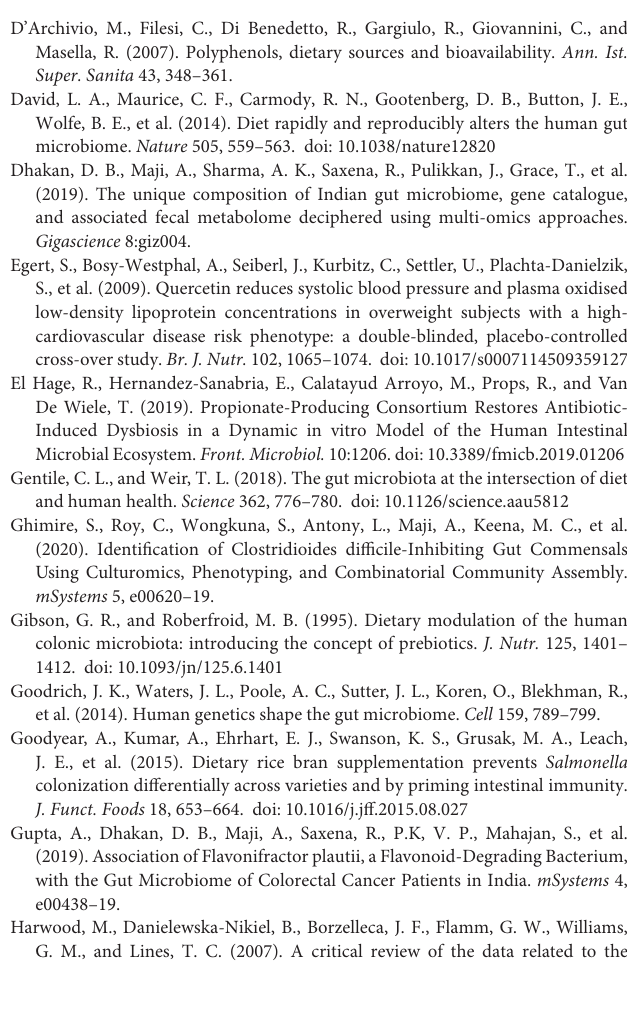
Supplementary Figure 3 | Impact of quercetin (QC) and rice bran (RB) supplementation on bacterial taxonomy. Species-wise variation of the most abundant (top 25) of the bacterial taxa determined by shotgun metagenome sequencing at day 21 (endpoint) for control, QC, RB, and QC + RB conditions in triplicate. Supplementary Figure 4 | Heatmap depicting the functional pathways in the metagenomes at day 21 obtained from shotgun metagenomic sequencing. KEGG modules obtained from GHOSTKOALA for each metagenomic sequence was plotted as either complete, 1 block missing, 2 blocks missing or incomplete. Supplementary Figure 5 | Biplot showing ordination of short-chain fatty acid production and bacterial communities formed at day 21 in control, QC, RB, and QC + RB conditions. Abundances of the bacterial communities at day 21 determined by shotgun metagenomics were used with SCFAs profiles of day 21 to generate the plot. Supplementary Table 1 | List of all differentially abundant taxa in medium with quercetin (QC), medium with rice bran (RB) and medium with both quercetin and rice bran (QC + RB) compared to control. DESEq2 was used in shotgun metagenome sequences on day 21 for identification of differentially present taxa in the quercetin and rice bran supplemented media conditions when compared to